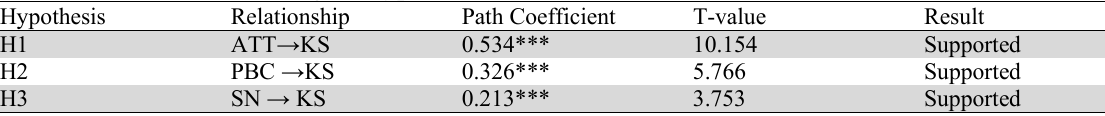
Fig. 1. Results of the Structural Model Path Coefficients and Testing of Hypothesis